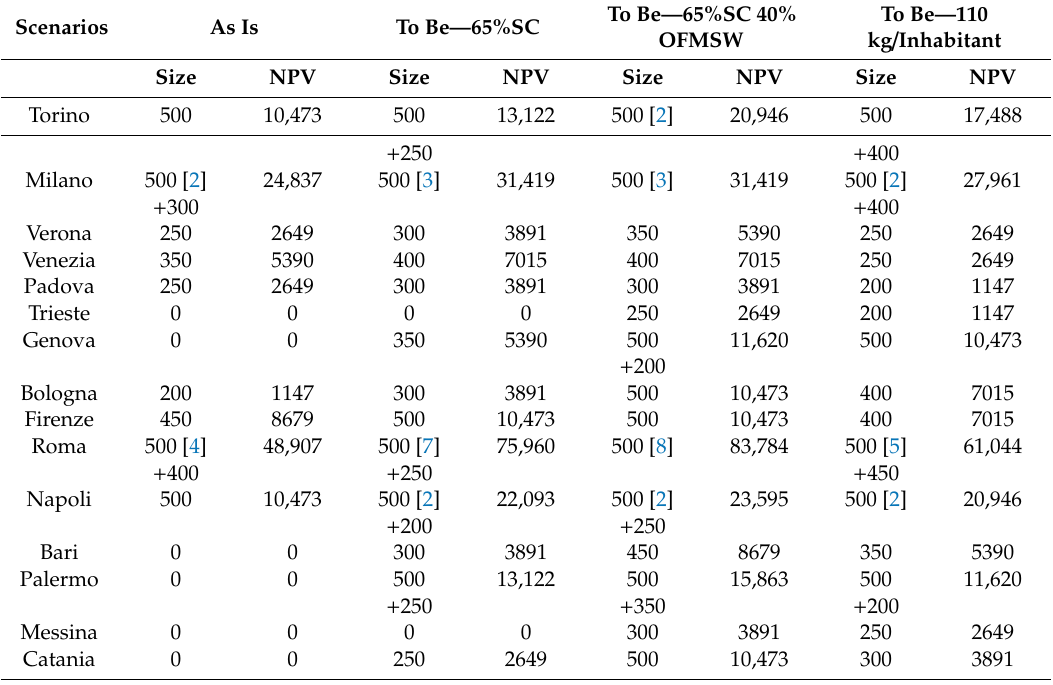
Table 11. Definition of plant size and calculation of economic profit (thousand € )—alternative scenario (joint implementation biomethane producer and methane